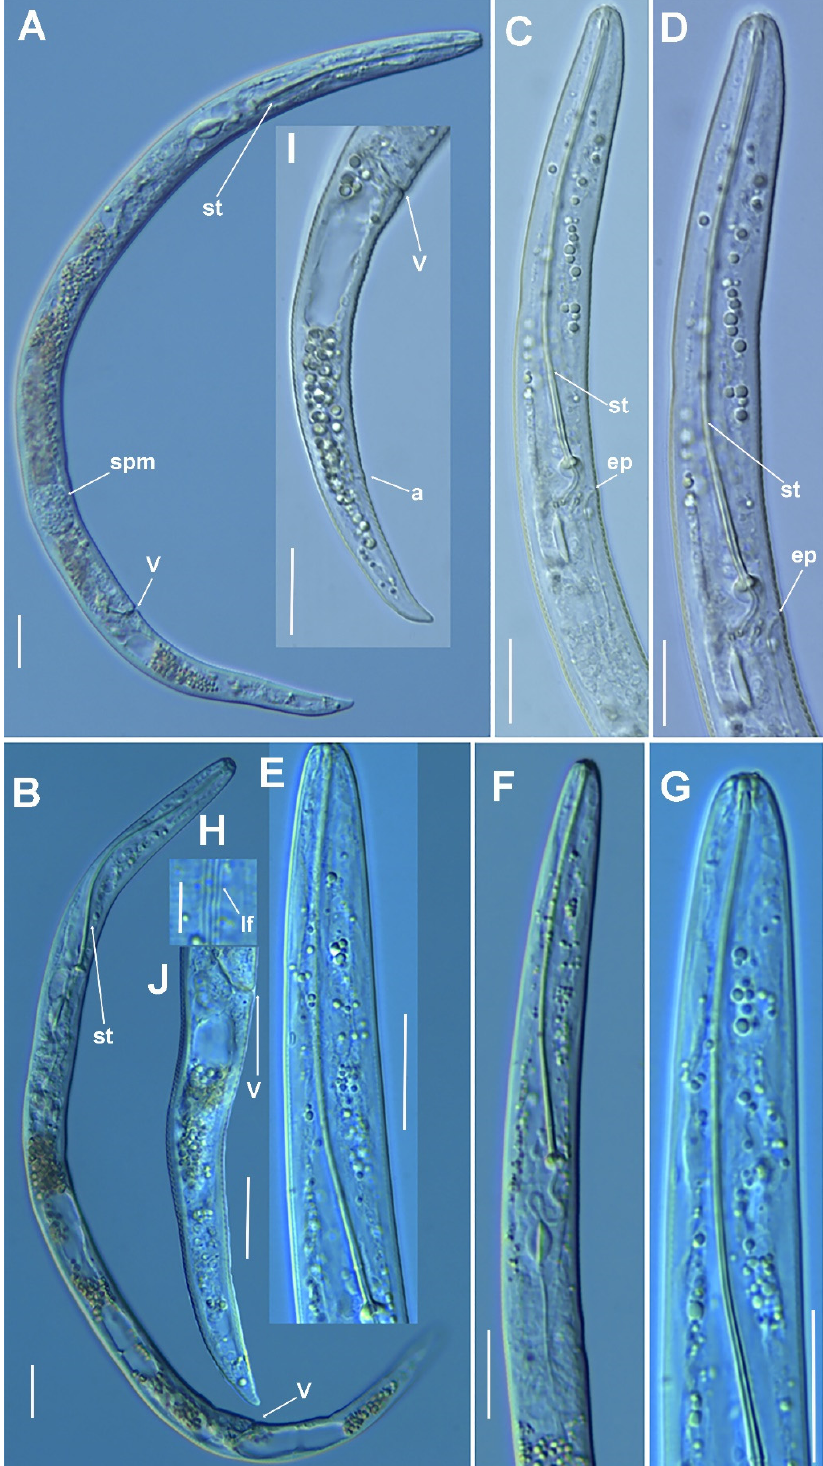
Figure 13. Micro-photomicrographs of Paratylenchus wuae Yu, Ye & Powers, 2016 female. ( A , B ) Whole female with stylet, vulva and spermatheca arrowed; ( C–G ) Pharyngeal and stylet regions; ( H ) Detail of lateral fields; ( I – J ) Female posterior region with vulva and anus (arrowed). Scale bars ( A – G , I , J = 20 μ m; H = 10 μ m). (Abbreviations: a = anus; ep = excretory pore; lf = lateral field; spm = spermatheca; st = stylet; V = vulva).